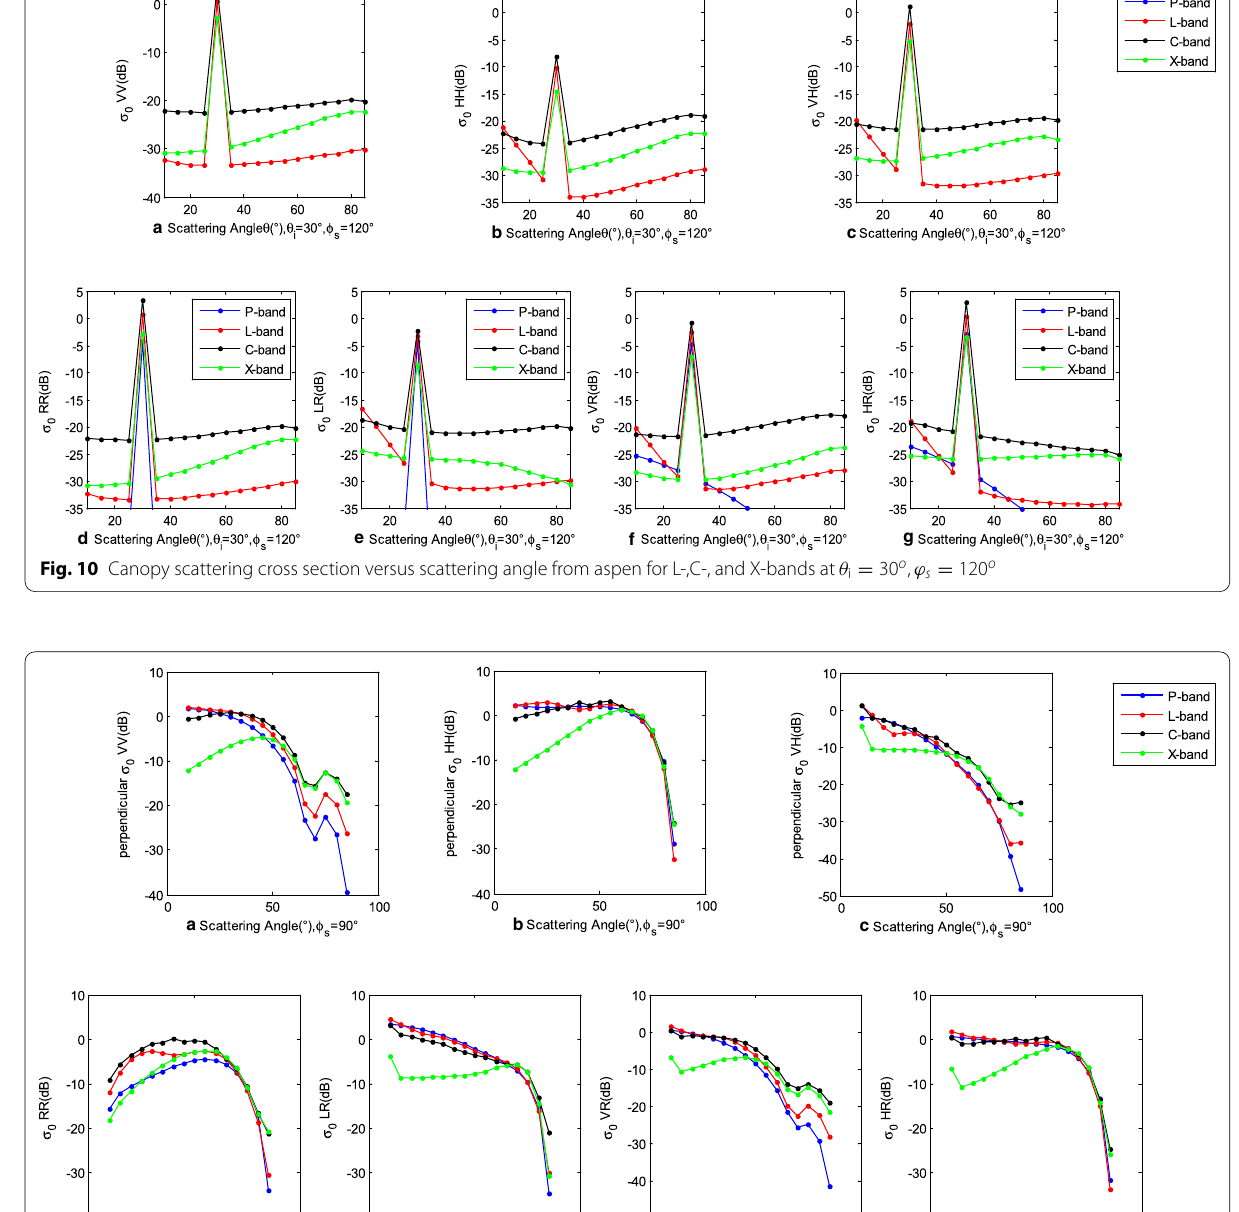
decrease sharply for larger specular angles except for RR polarization. The specular scattering firstly increase and then decrease for RR polarization.